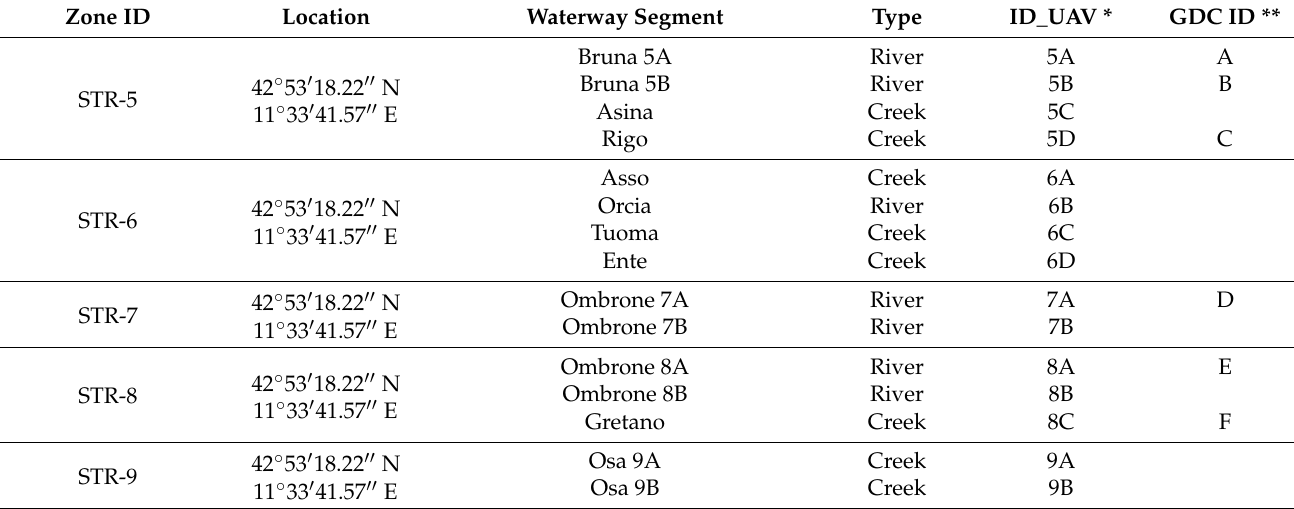
Figure 1. The study zones (highlighted in blue) selected within the Regione Toscana area (highlighted in red) and a zoom of two Osa River reaches where detailed information was acquired (highlighted in white). Table 1. Study area and experimental campaign description (* UAV’s flight ID, ** Ground-data collection